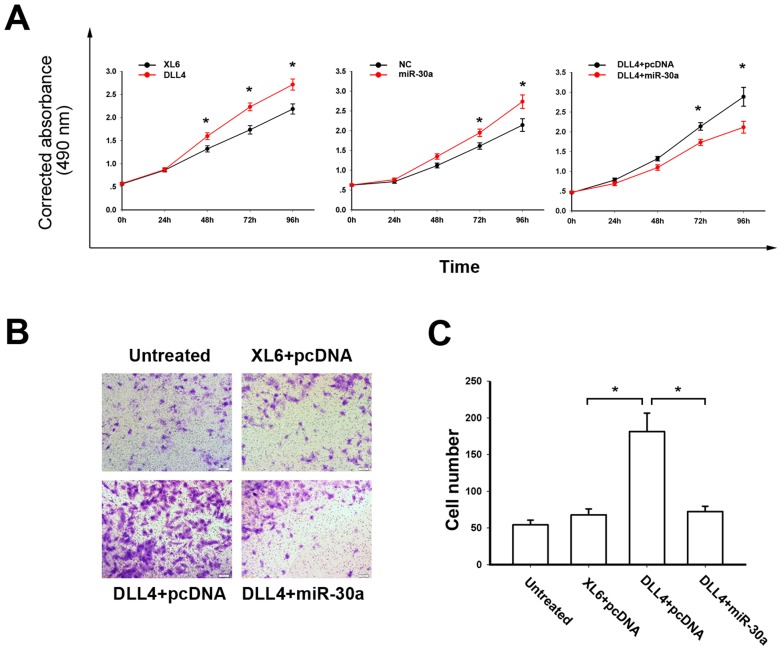
miR-30a and DLL4 played opposite roles in the proliferation and migration of HUVEC-C cells.(A) DLL4-transfected HUVEC-C cells gained more proliferation capacity than control cells detected by MTS assay (left panel), while miR-30a suppressed HUVEC-C cell proliferation relative to control cells (middle panel). HUVEC-C cells were co-transfecting with either miR-30a and DLL4 or DLL4 and pcDNA3.0 and showed that miR-30a partially inhibited the DLL4-stimulated proliferation (right panel). (B) HUVEC-C cells transfected with DLL4 vector and miRNAs control vector (pcDNA) gained more migration capacity than cells transfected with double negative control vectors (XL6+pcDNA). However, HUVEC-C cells transfected with DLL4 vector and miR-30a gained less migration capacity than cells transfected with DLL4 and pcDNA vectors. (C) The numbers of migrated cells in the four groups are shown in bars. Data are presented as the mean ± SEM. *statistics significant.